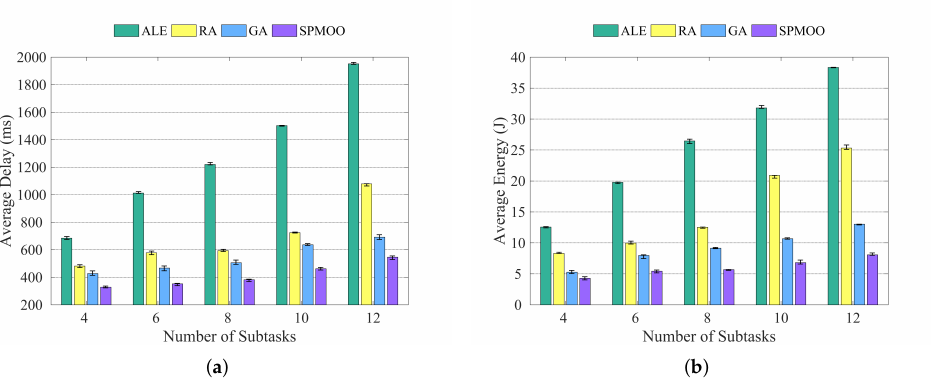
Figure 5. Comparison of the four algorithms when the number of subtasks is {4, 6, 8, 10,